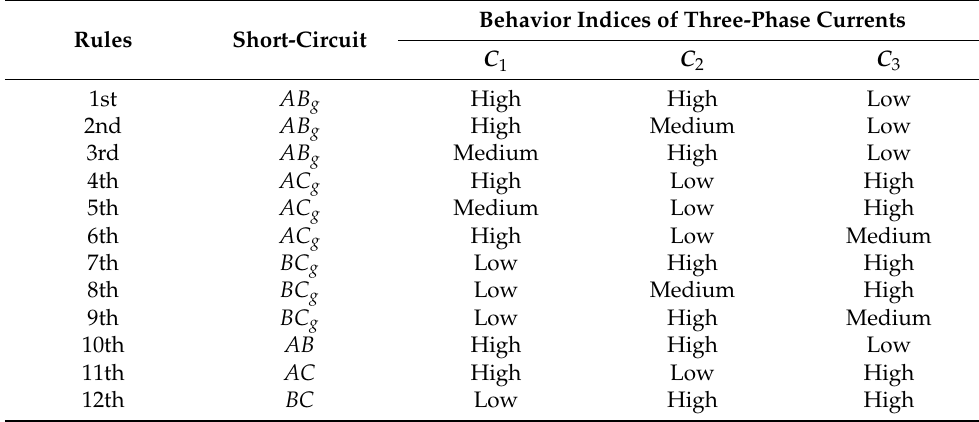
Table 3. FIS rules set to classify two-phase short-circuit.